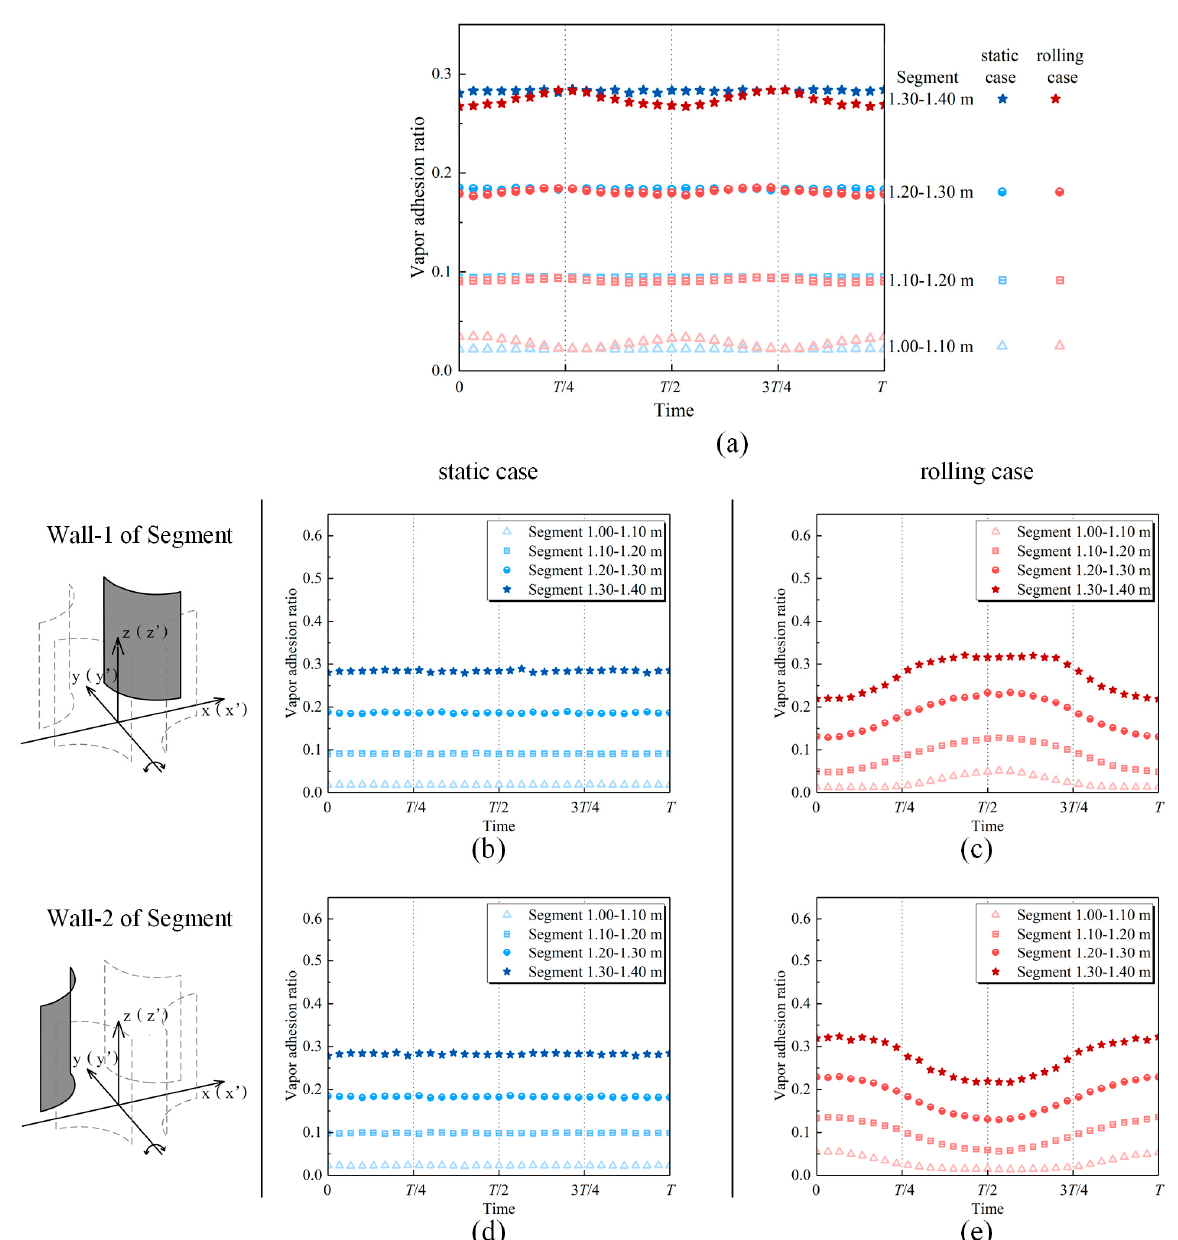
Figure 7. Instantaneous vapor adhesion ratio. ( a ) Segment; ( b ) Wall-1 in the static case; ( c ) Wall-1 in the rolling case; ( d ) Wall-2 in the static case; ( e ) Wall-2 in the rolling case. The tendencies of the vapor adhesion ratio are different at the upper position (Segment 1.20–1.40 m) due to the combined effects of the vapor volume fraction and the transverse flow. At the beginning of rolling motion ( t = 0), the vapor adhesion ratio at Wall-1 is less than that under static state due to transverse flow. Then, it gradually increases to approximately the value under static state when the subchannel reaches the extreme position ( t = T /4). After that, the incoming fluid temperature in the vicinity of